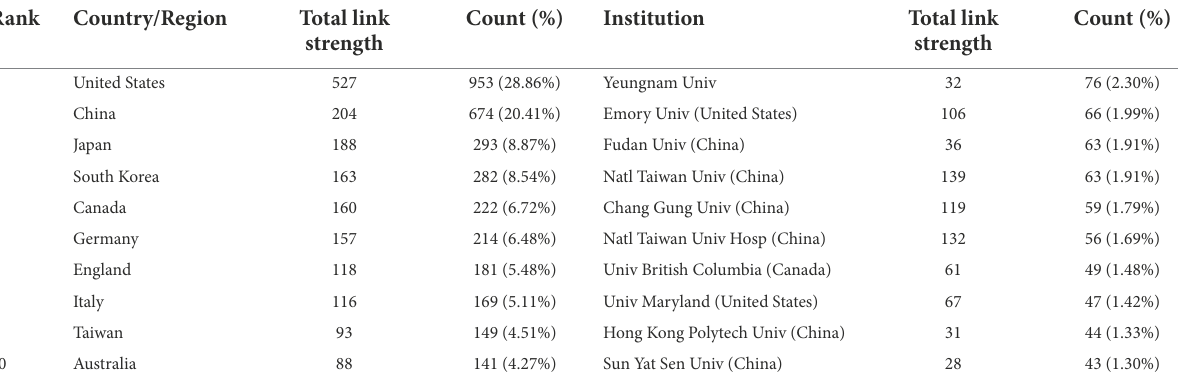
TABLE 1 Top 10 countries/regions and institutions related to stroke motor function